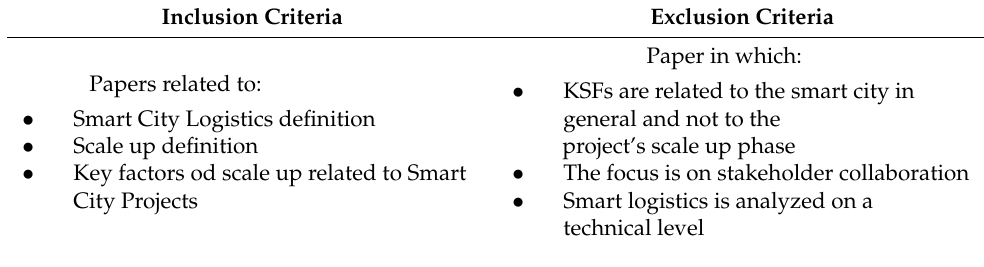
Table 3. Inclusion and Exclusion